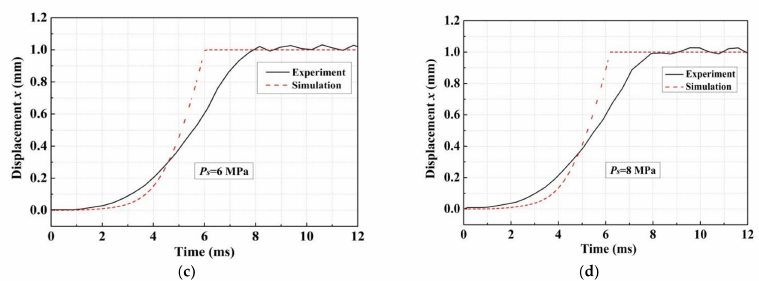
Figure 12. Step responses of VCM-DHPV under different supply pressures ( u = 240 V, α = 45 ◦ ):